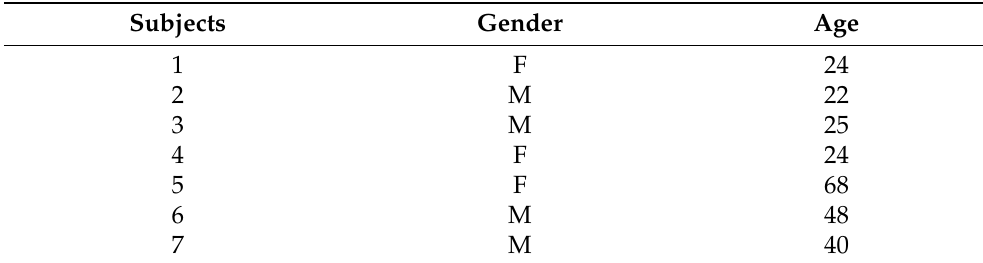
Table 1. The gender and age of the participants of our tests.